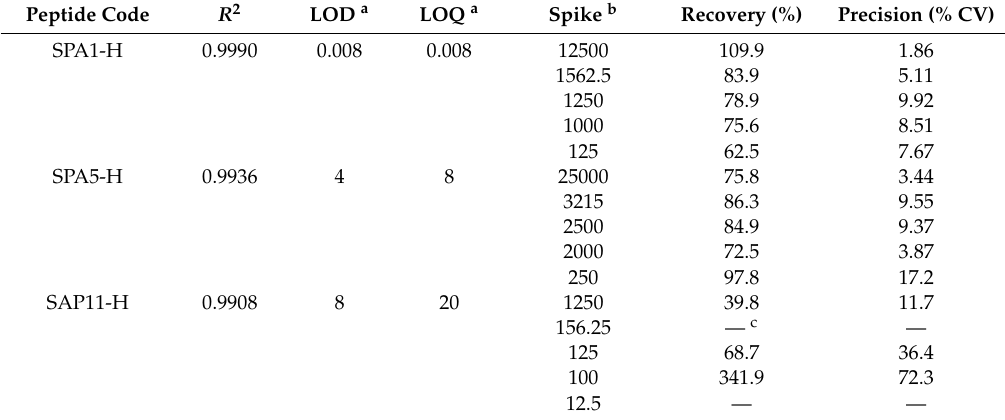
Table 2. Coe ffi cient of determination, limit of detection (LOD), limit of quantification (LOQ), recovery, and precision of the target